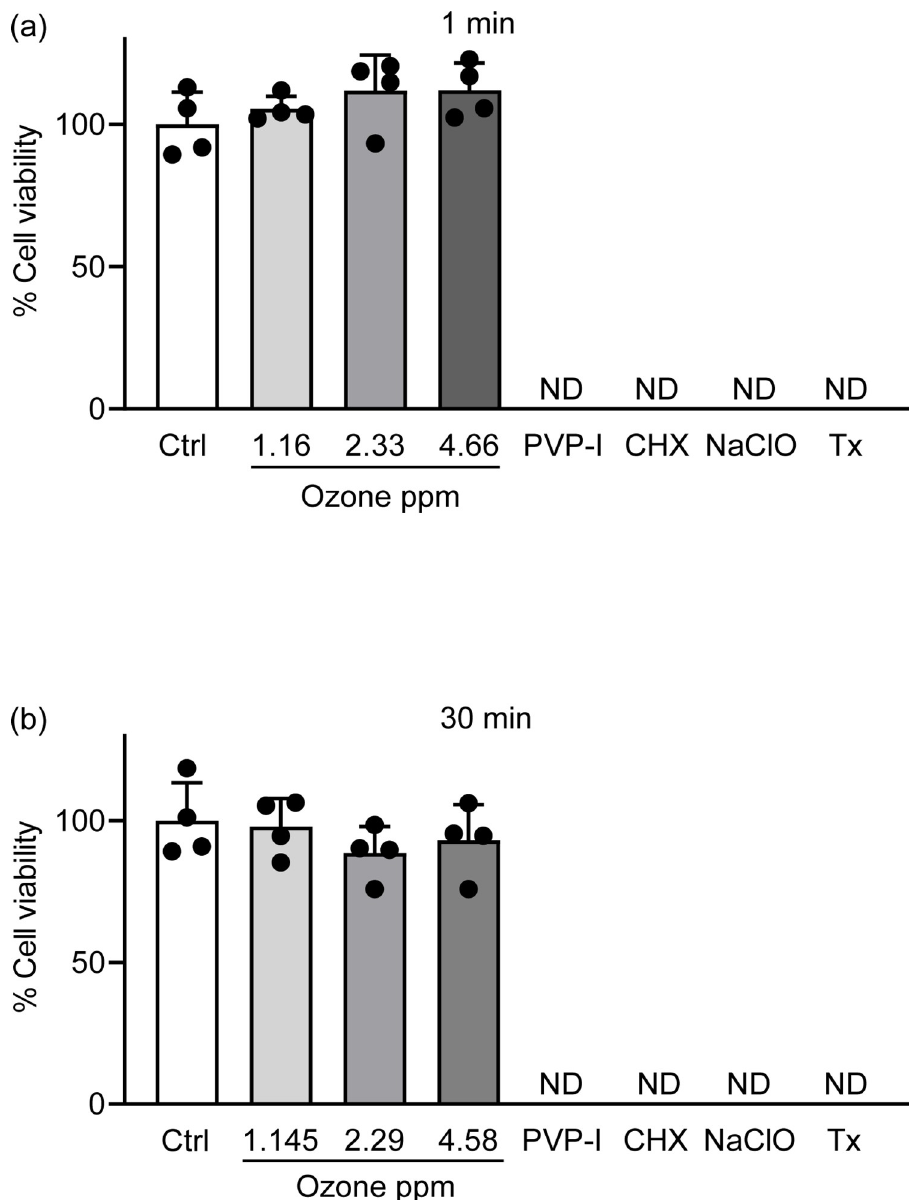
Fig 5. Cell viability of human gingival epithelial cells after exposure to ozone ultrafine bubble. Human gingival cell line Ca9-22 were exposed to PBS containing 1–5 ppm ozone ultrafine bubble, 0.1% Povidone iodine, 0.2% Chlorhexidine, 0.1% NaClO or 0.5% Triton X-100 for (a) 1 min or (b) 30 min. MTT (3-(4,5-Dimethyl-2-thiazolyl)- 2,5-diphenyl-2H-tetrazolium bromide) assays were performed to determine cell viability. Data represent the mean ± SD of quadruplicate determinants, and were evaluated using Dunnett’s multiple-comparisons test. ND stands for undetected and indicates below the detection limit.